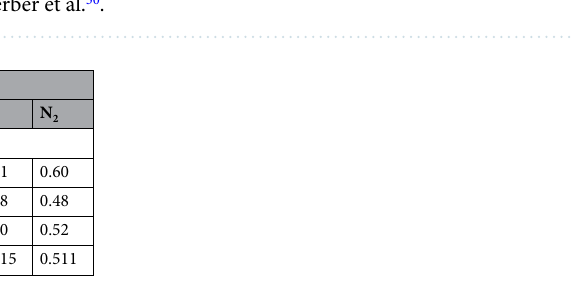
Table 6. Time-averaged mole fraction of product gas validated with the experimental data of Gerber et al. 30 .